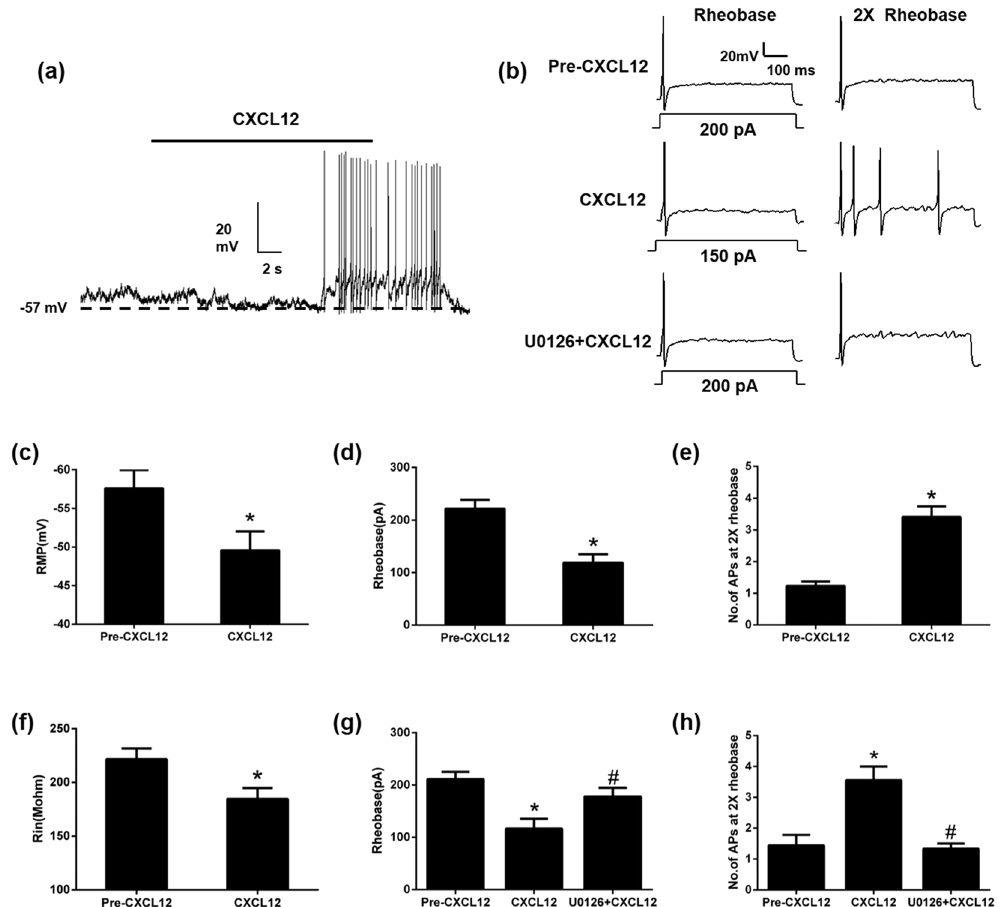
Figure 5. CXCL12 (100 nM) increased the excitability of DRG neurons from CCD mice on postoperative day 7, ERK pathways may be involved in the hyperexcitability of DRG neurons after CCD. ( a ) Typical current-clamp recordings of CXCL12-induced membrane potential depolarization and action potential discharges. ( b ) Typical traces of APs evoked by a 500-ms depolarizing current pulse at 1 and 2 × rheobase before, during CXCL12 application or CXCL12 application with U0126 (20 μ M). ( c ) Mean RMP before (Pre-CXCL12) and during CXCL12 application (n = 17), * P < 0.05 vs. Pre-CXCL12, paired t-test. ( d , e ) CXCL12 significantly decreased the mean rheobase and increased the number of APs evoked by a depolarizing current at 2 × rheobase (n = 17). * P < 0.05 vs. Pre-CXCL12, paired t-test. ( f ) Mean input resistance (R in ) before (Pre-CXCL12) and during application of CXCL12 (n = 17), * P < 0.05 vs. Pre-CXCL12, paired t-test. ( g , h ) CXCL12 decreased the mean rheobase and increased the number of APs evoked by a depolarizing current at 2 × rheobase, but U0126 treatment inhibited these changes. (n = 10) * P < 0.05 vs. Pre-CXCL12, # P < 0.05 vs. CXCL12, repeated measure one-way ANOVA followed by Tukey’s post hoc